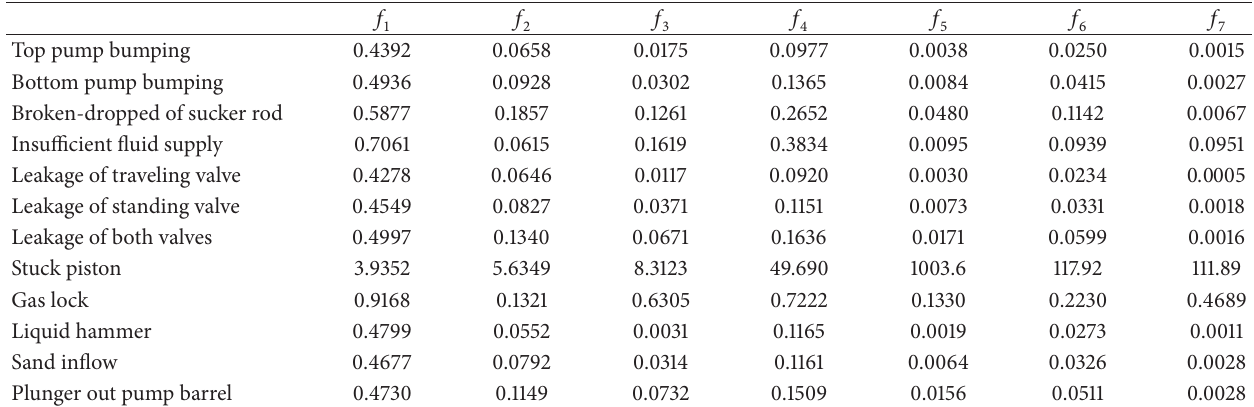
Table 2: Geometric Moment Vectors of typical faults indicator card.